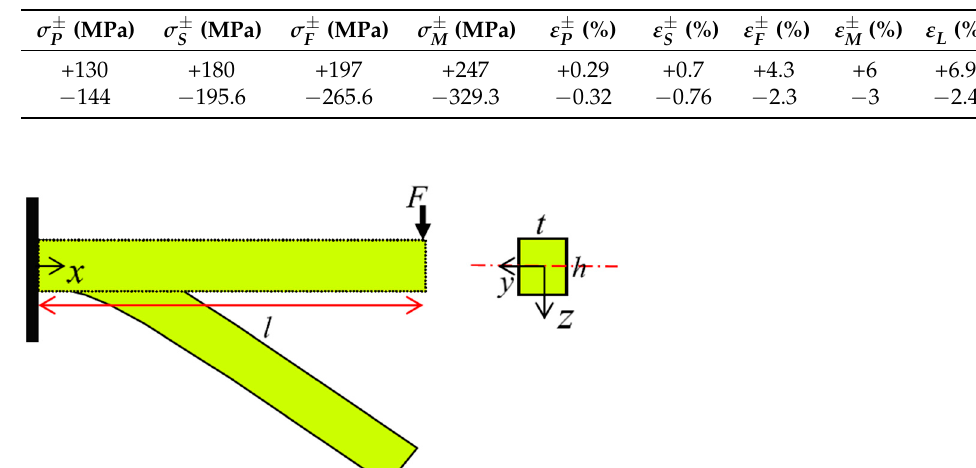
Figure 15. Hysteric tensile and compression tests for martensite SMA beam at room temperature. Table 5. Material properties extracted from experimental tests.